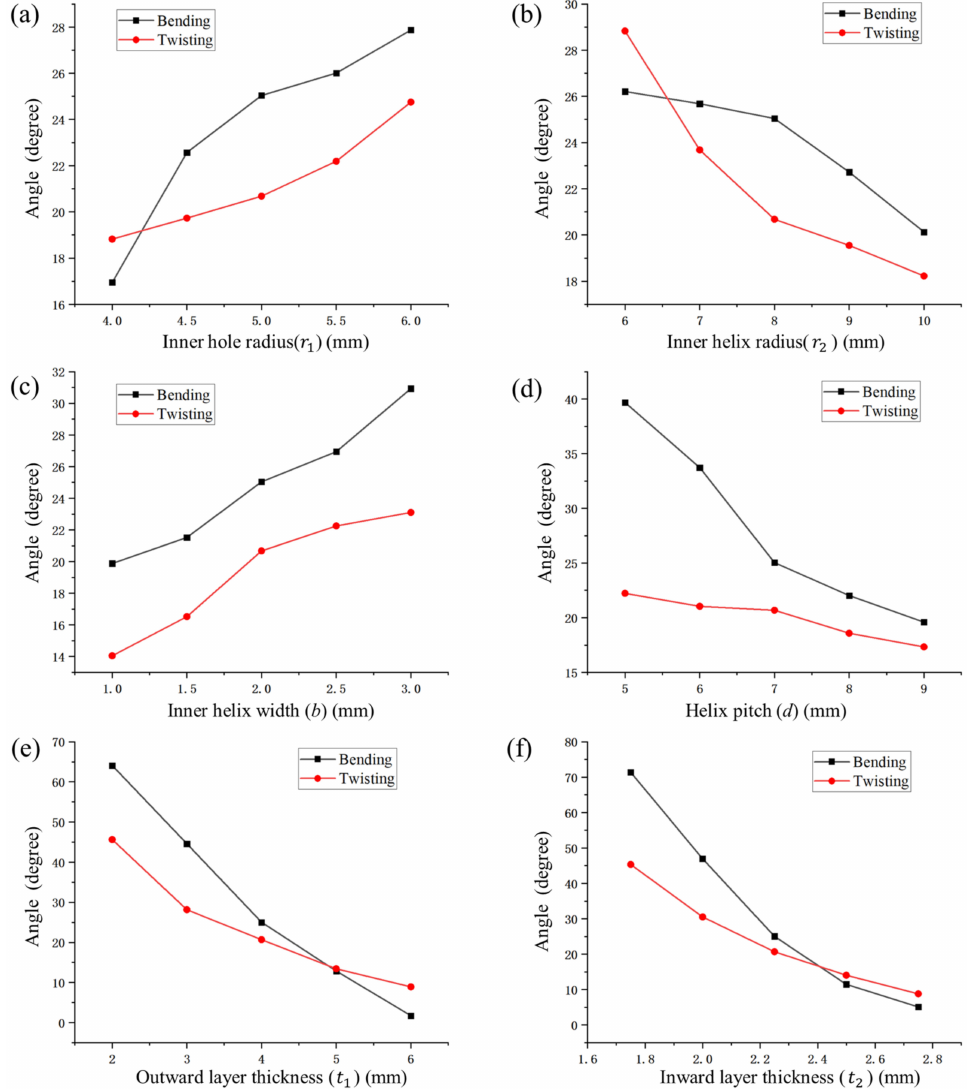
Figure 9. Analysis of structural parameters: ( a ) internal radius; ( b ) width of inner helix surface; ( c ) length; ( d ) pitch; ( e ) outer layer thickness; ( f ) inner layer